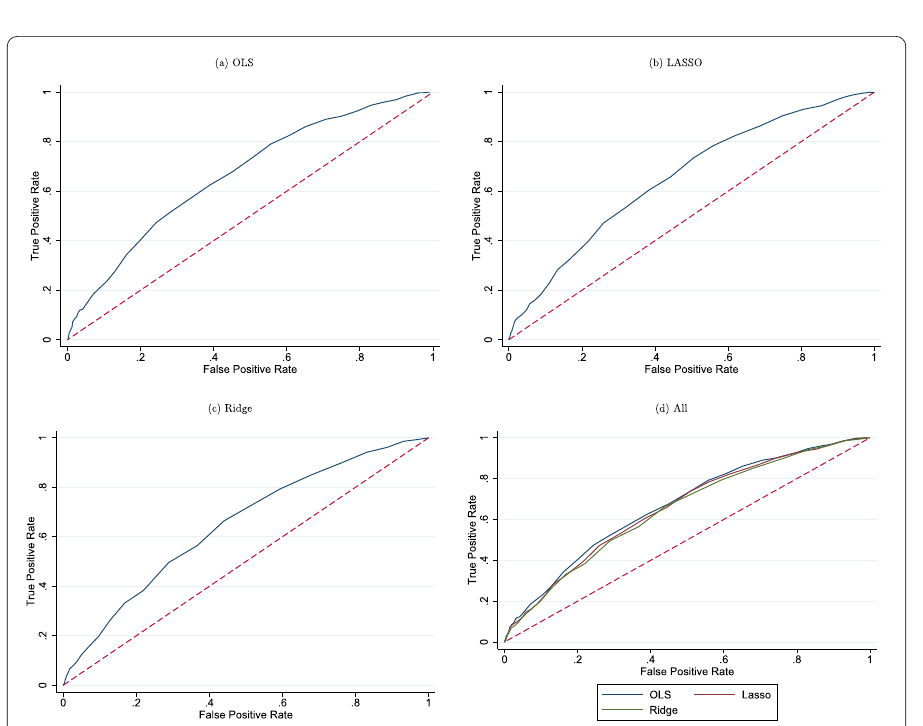
Figure A.6 ROC curves. Large model—verification